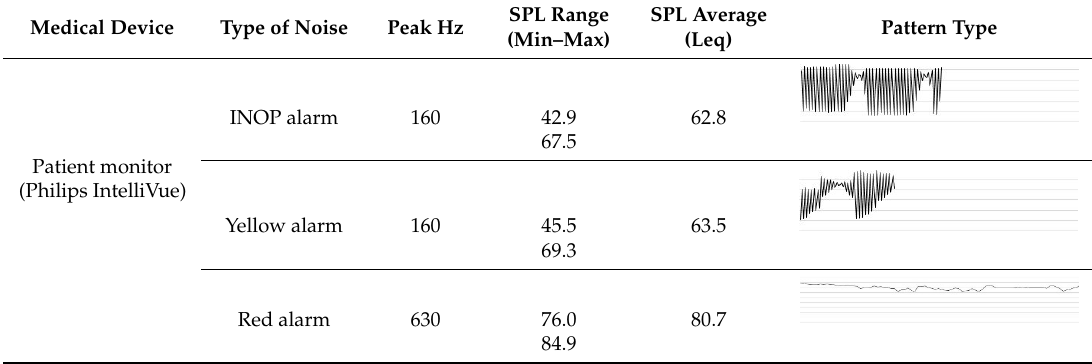
Table 3. Wave pattern analysis of noise generated by various medical devices in the ICU. Medical Device